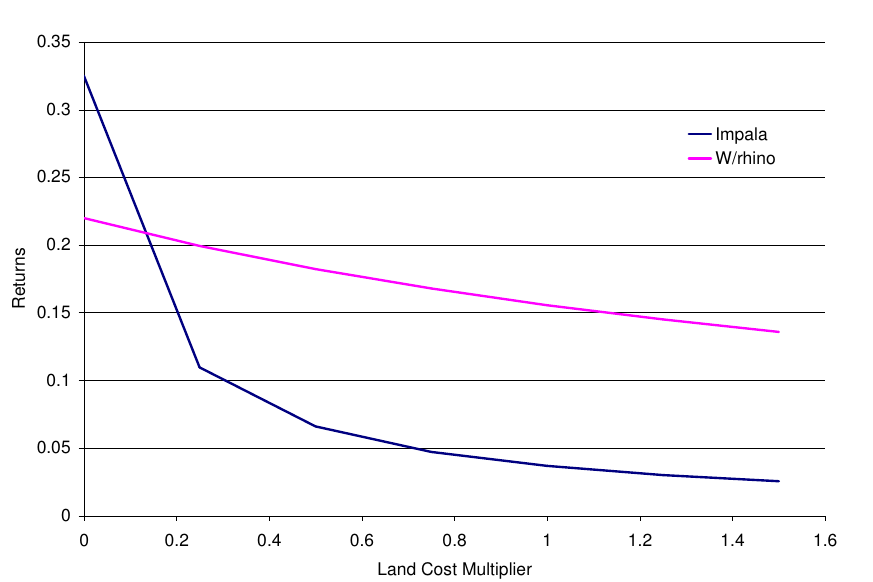
of land increases, eventually better returns on investment are obtained from white rhino rather than from impala. It is therefore to be expected that the optimal population of each species will be affected by the value of